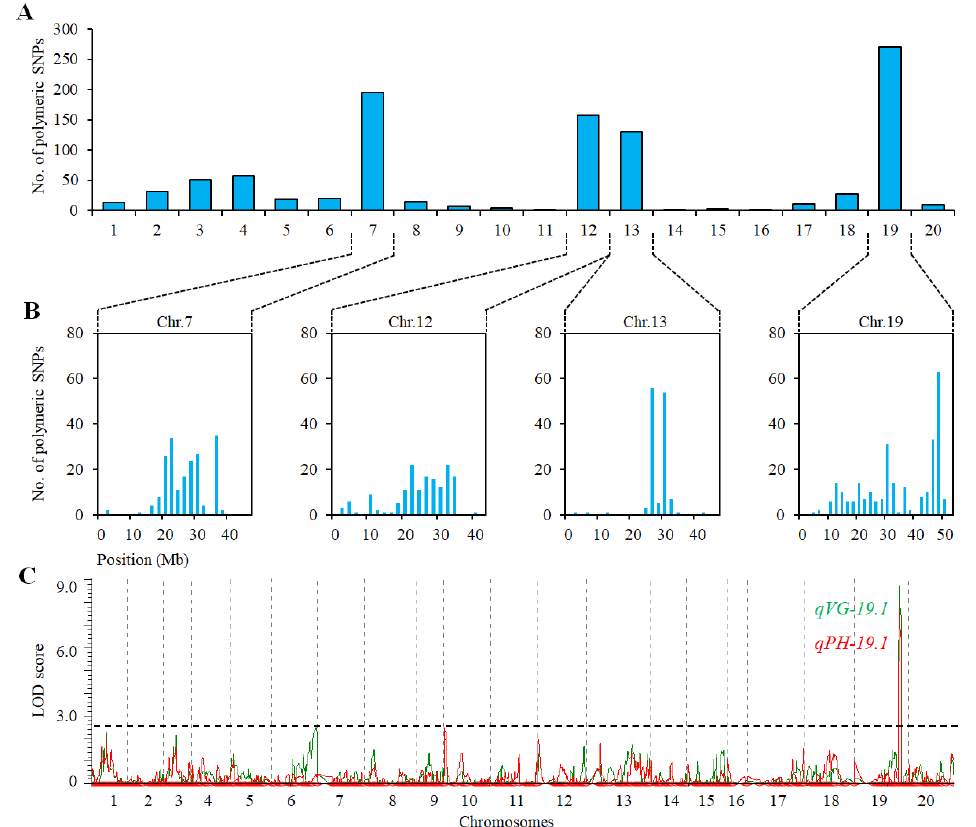
Figure 3. QTL mapping of VG and PH in the ZH39 × NY36-87 RIL population. ( A ) Numbers of polymorphic SNPs on all chromosomes between two DNA bulks, EB1 and VB1. ( B ) Four putative regions for QTLs associated with VG and PH; the bars represent the number of polymorphic SNPs between EB2 and VB2 in a 2 Mb region. ( C ) Composite interval QTL mapping for VG and PH by genotyping 50 phenotypically extreme individuals from ZH39 × NY36-87; VG (green) and PH (red). Table 2. QTLs statistics associated with VG and PH in the ZH39 × NY36-87 F 7